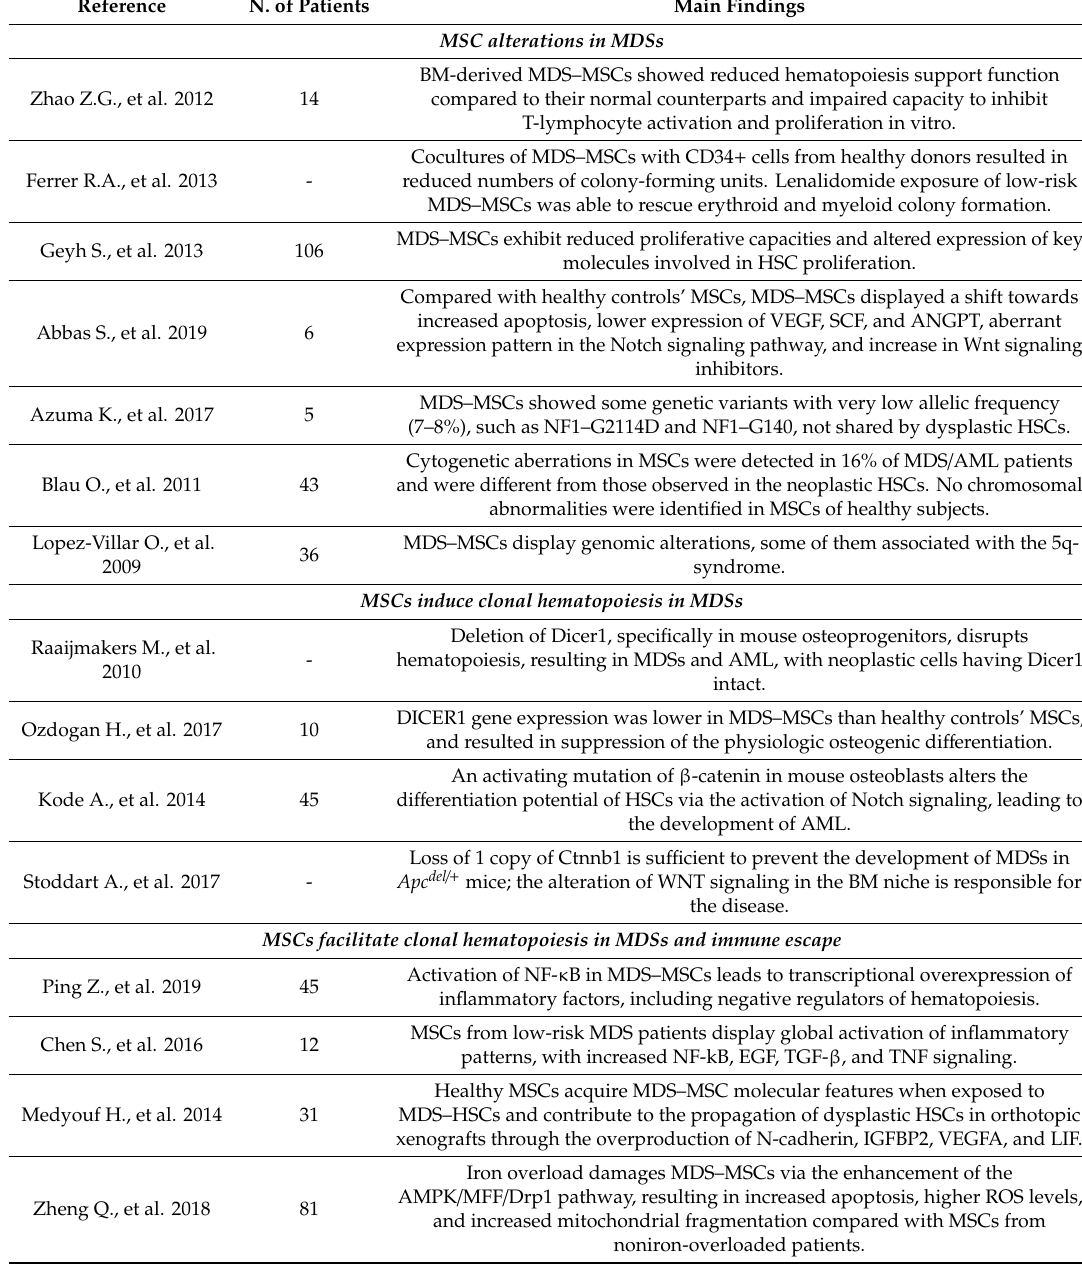
Table 3. Pathogenic role of mesenchymal stem cells (MSCs) in myelodysplastic syndromes (MDSs). MDS–MSCs, MSCs from patients with MDS; BM, bone marrow; AML, acute myeloid